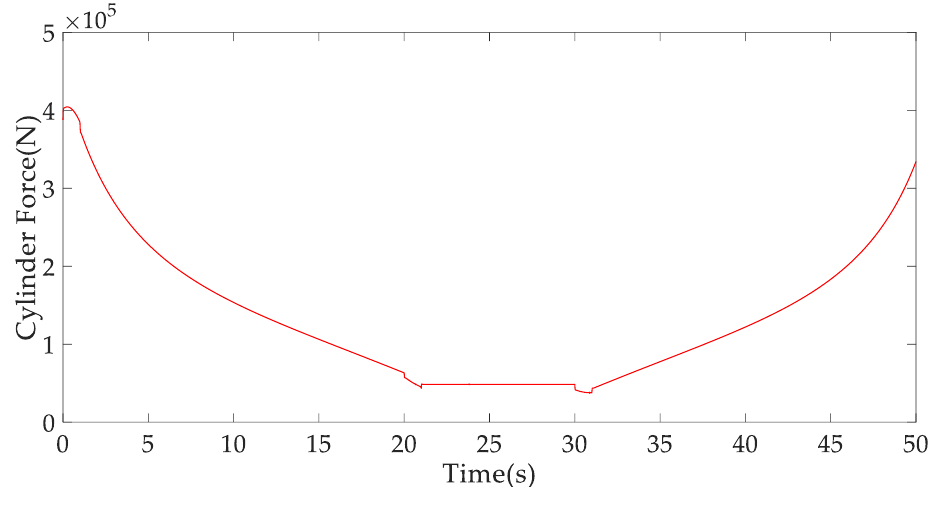
Figure 12. The cylinder force in NRC.